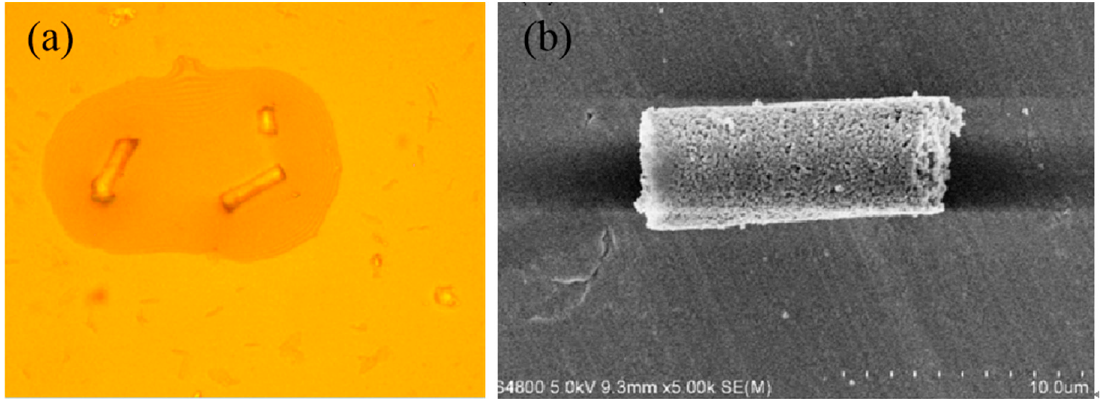
Figure 14. Optical microscopy and scanning electron microscopy of tubular micromotor.